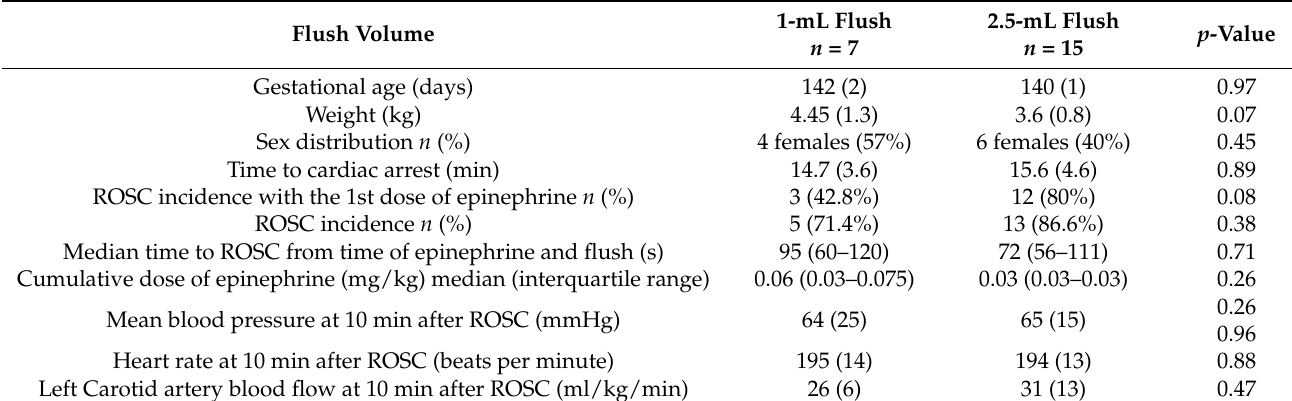
Table 1. Comparison of characteristics between lambs that received 1-mL and 2.5-mL flush volumes after 0.03 mg/kg low UVC